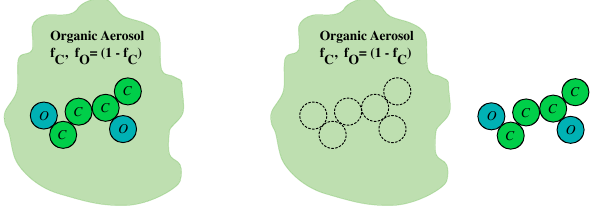
Fig. 5. Solvation interactions in a simple group-contribution method for organics dissolved in an organic-aerosol